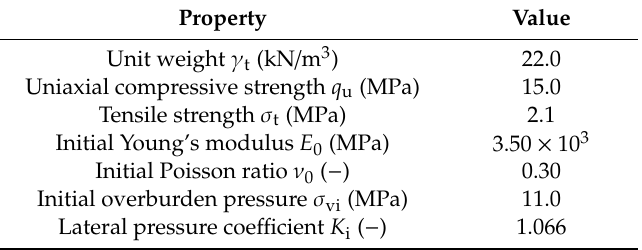
Table A7. Properties for the rock materials (nonlinear